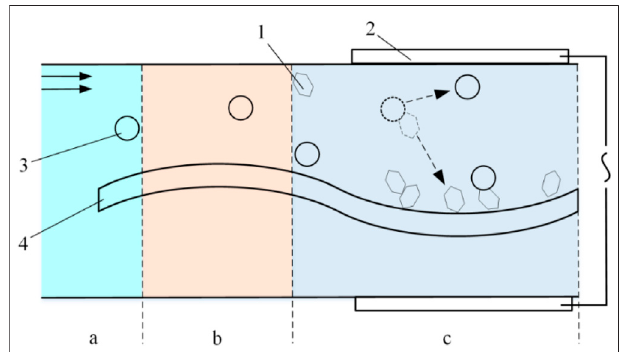
FIGURE 1 | Principle of liquid metal-abrasive fl ow polishing: 1-Abrasive particle, 2-Electrode, 3-Liquid metal particle, 4-Workpiece, a-Inactive area, b-Buffer area, c-Active